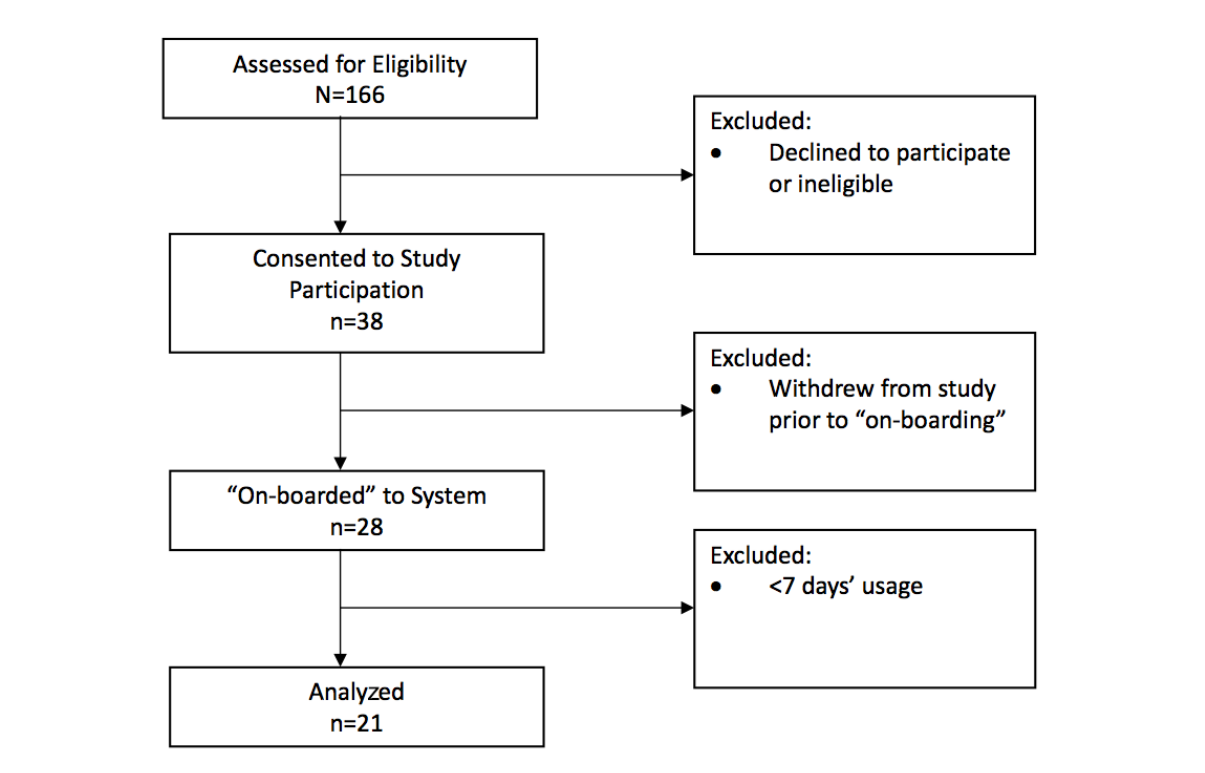
Figure 3. Patient